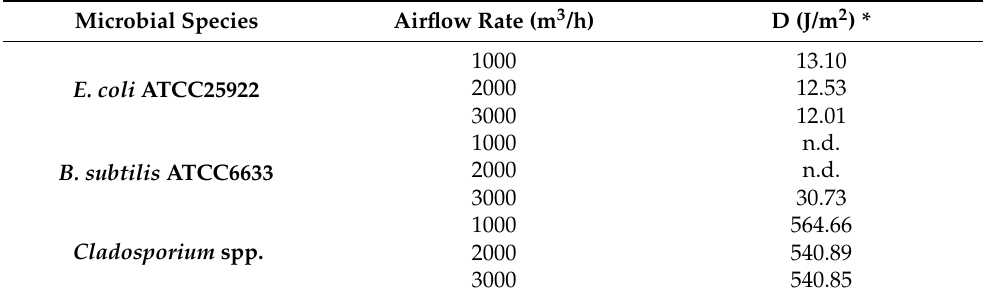
Table 3. UV-C dose (D) for each microbial species used in the sanitation experiments in the test rig, at each airflow rate (ISO,